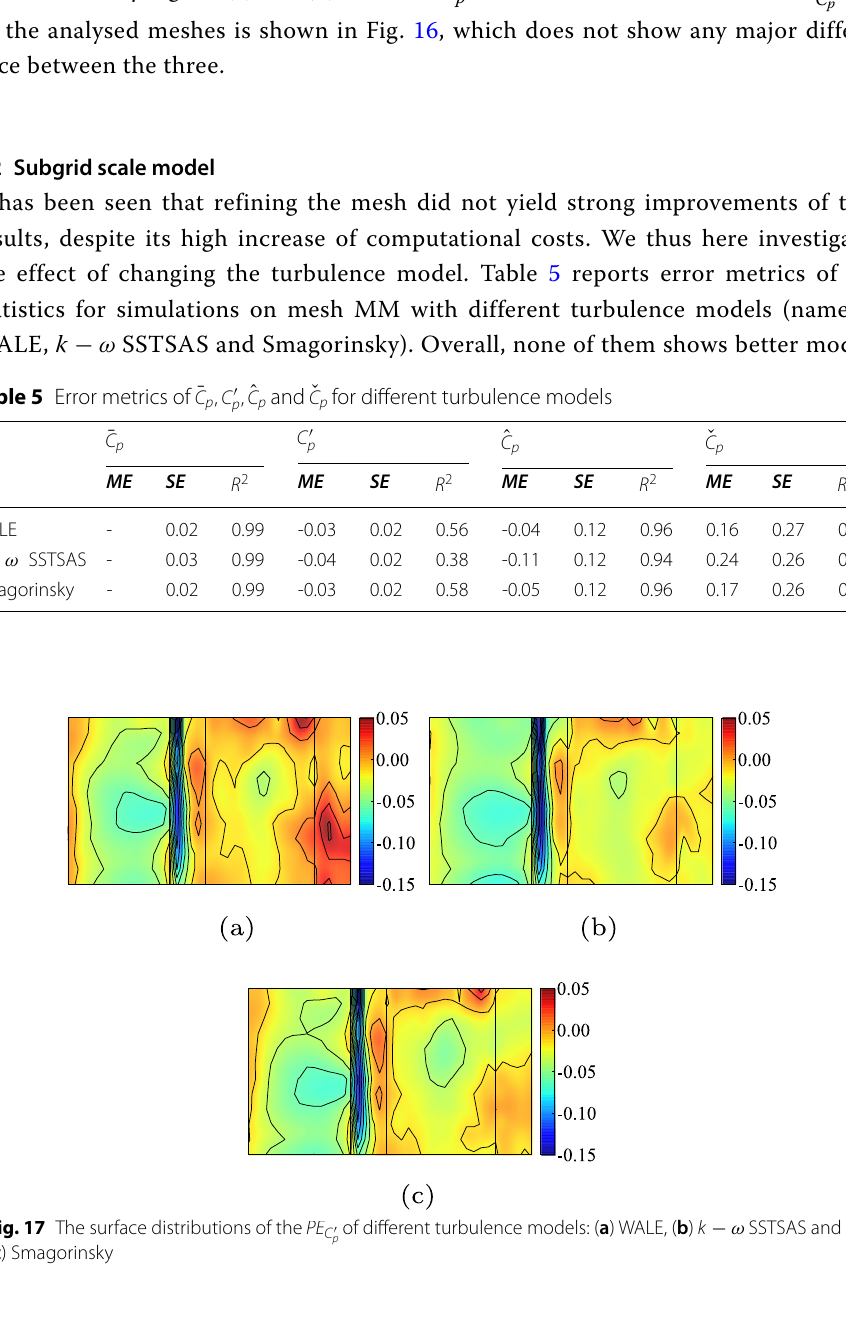
of different turbulence models: ( a ) WALE, ( b ) k − ω SSTSAS and p